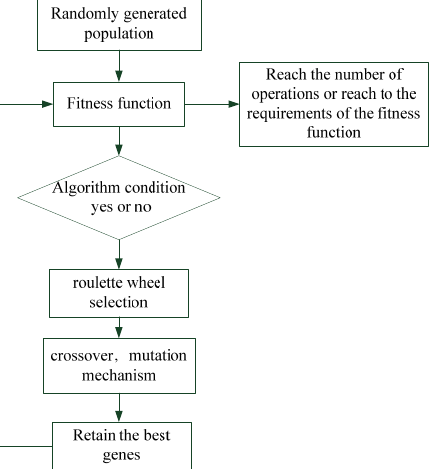
Figure 10. Flowchart of the genetic algorithm (GA) used in the intraocular lens (IOL) design.